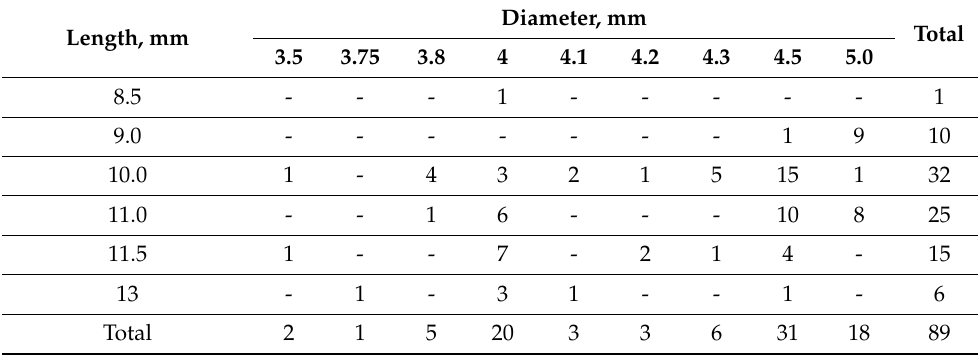
Different bone substitute materials were used for maxillary sinus augmentation (Table 1). Patients undergoing bilateral sinus augmentation received the same biomaterial in both sides. Considering the graft as the unit, mesiodistal and vertical resorption at the latest follow-up averaged 9.3 ± 20.7% and 5 ± 9.9% of the postoperative size, respectively. Table 2 describes the implant distribution according to diameter and length, while Table 3 describes the implant distribution according to the maxillary site. Of the 89 implants inserted, the results of only 86 were considered because three implants had incomplete data regarding graft dimension change. Table 2. Implant distribution according to the diameter and length.